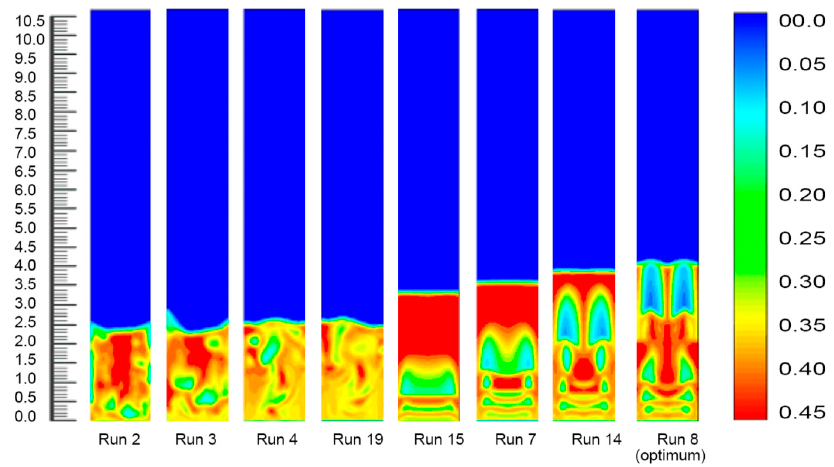
Figure 8. Bed dynamics at different set process combinations.